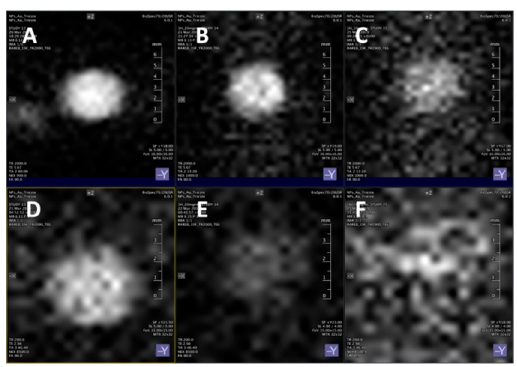
Figure 4. 19 F MRI Phantom experiments run on solutions of: upper panels, NP-C6OF-PEG at ( A ): 40 mg/mL; ( B ): 20 mg/mL; (C): 10 mg/mL; lower panels, NP-C6OF-PEG/C6OF-DO3AGd at ( D ): 40 40 mg / mL; ( B ): 20 mg / mL; (C): 10 mg / mL; lower panels, NP-C6OF-PEG / C6OF-DO3AGd at ( D ): mg/mL; ( E ): 20 mg/mL; ( F ): 10 mg/mL. 40 mg / mL; ( E ): 20 mg / mL; ( F ): 10 mg /